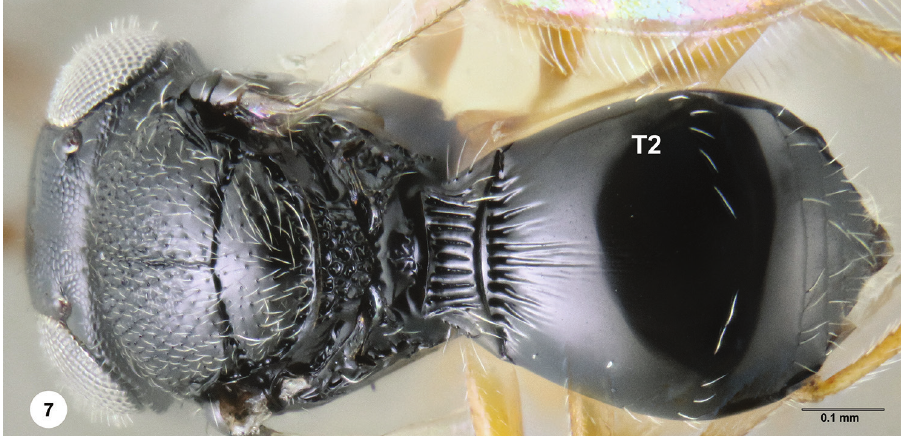
Figure 7. Telenomus podisi , female (DPI_FSCA 00010237), habitus, dorsal view. T2: second metasomal tergite.